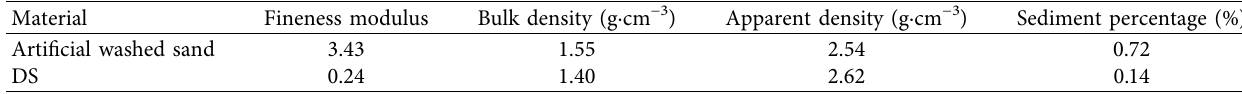
Table 2: Physical index of fine aggregate.